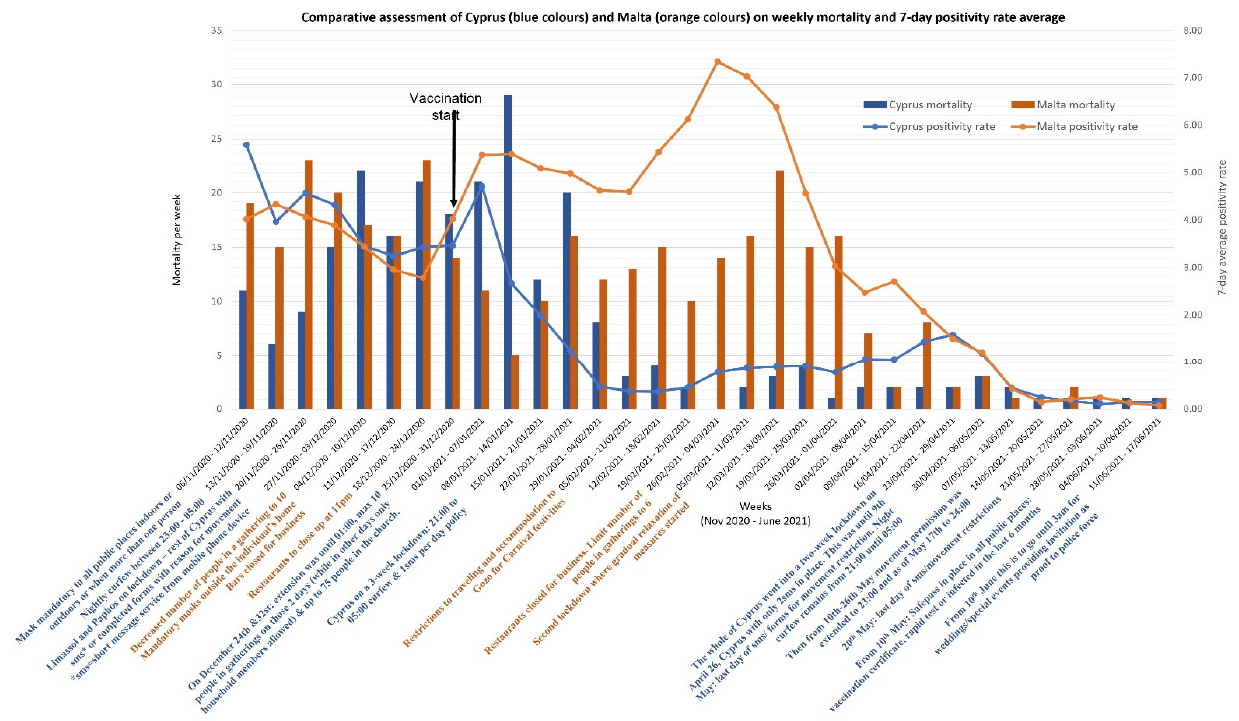
Figure 1. Comparative assessment of the cumulative vaccination population coverage in Cyprus and Malta across weeks according to the different doses. Black arrows represent the proportion difference between both islands for the same